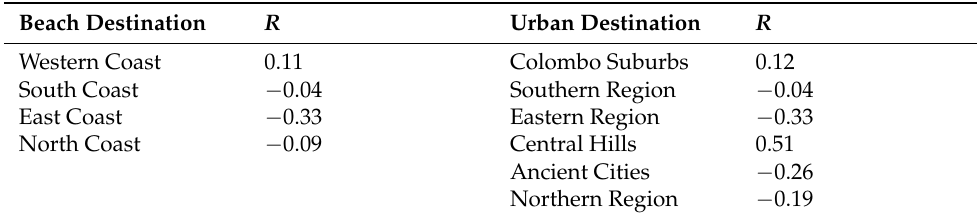
Table 3. Correlations between the HCI scores and average number of tourists who stayed in a par ‐ ticular destination.